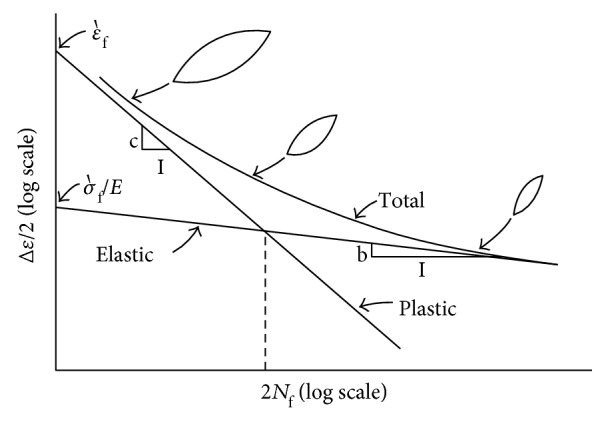
Strain-life curve [22].